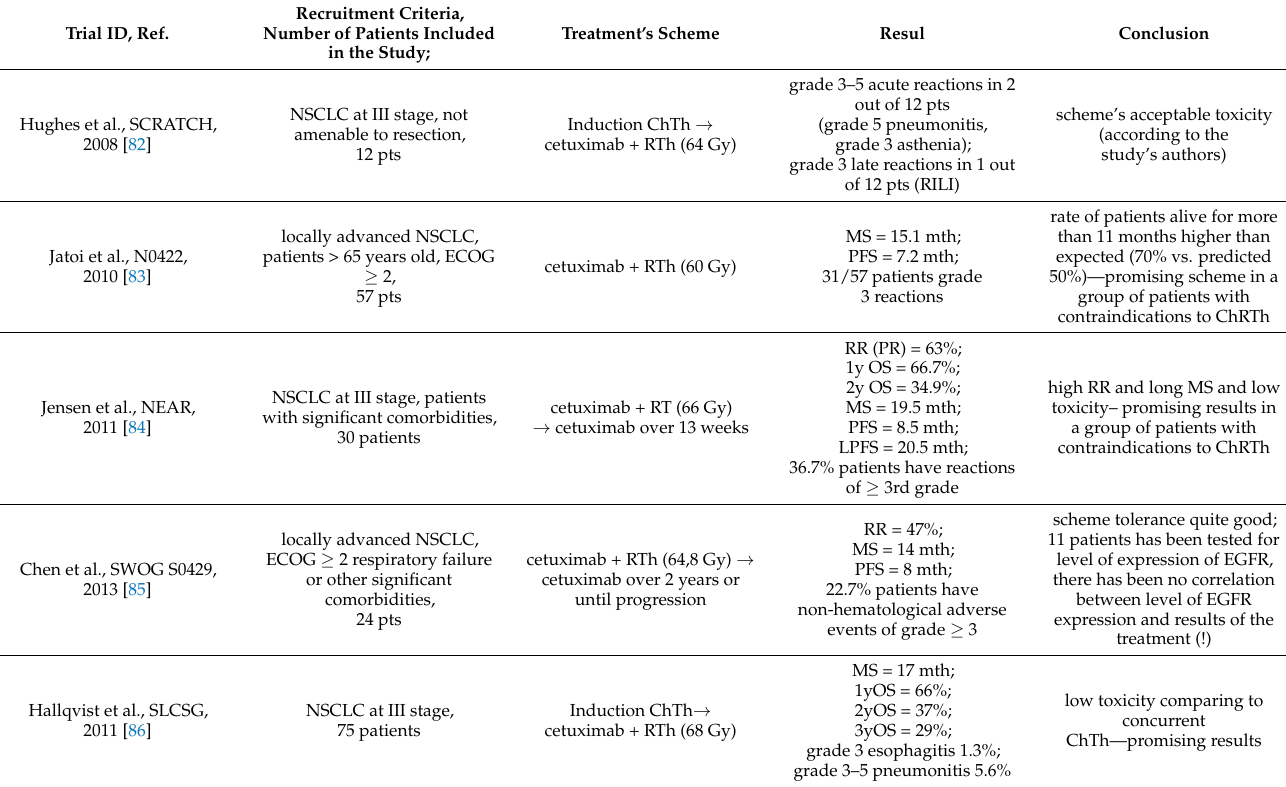
Table 3. Targeted therapies combined with radiotherapy in radical setting—results of the studies. Trial ID,